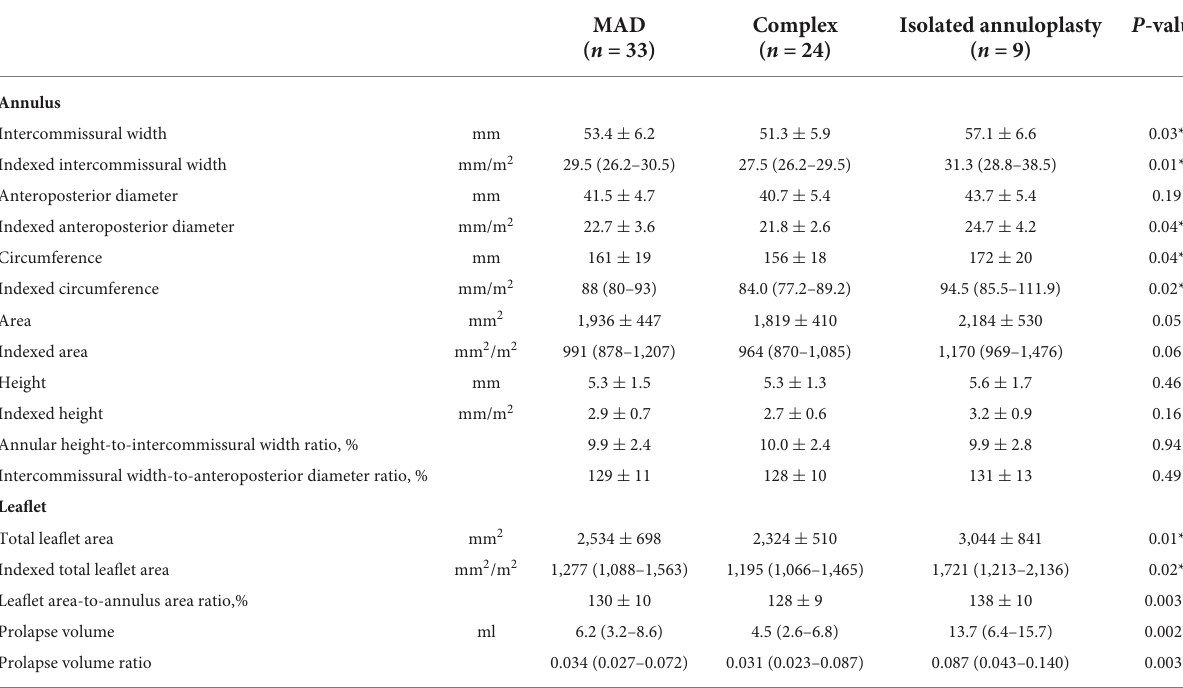
TABLE 4 Annular and leaflets measurements.